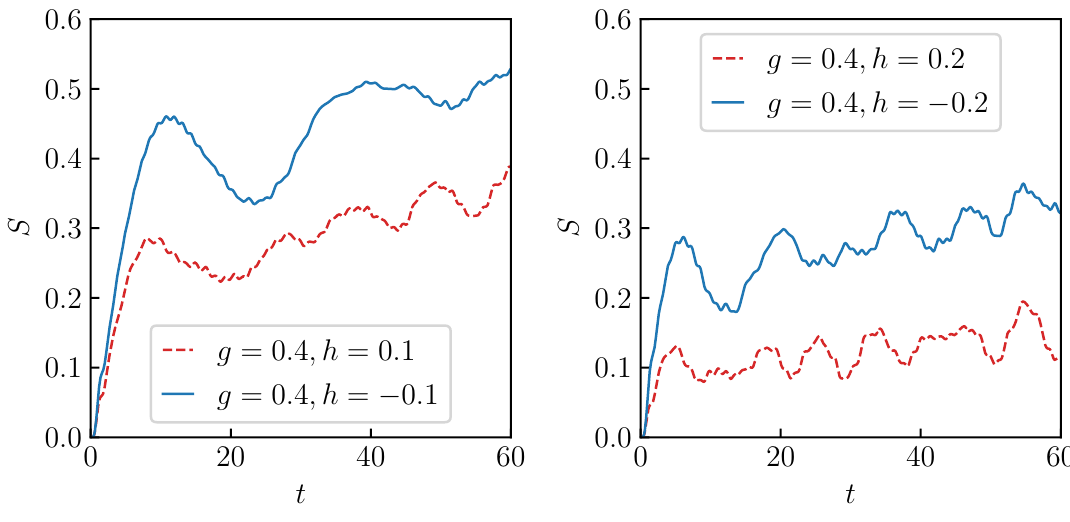
Figure 1.2: Time-dependence of entanglement entropy for the quenches displayed in Fig. 1.1. Note that anti-confining quenches (blue continuous lines) show a suppres- sion of entropy growth similar to the confining case (red dashed lines), albeit with a larger magnitude of entanglement entropy generated during the